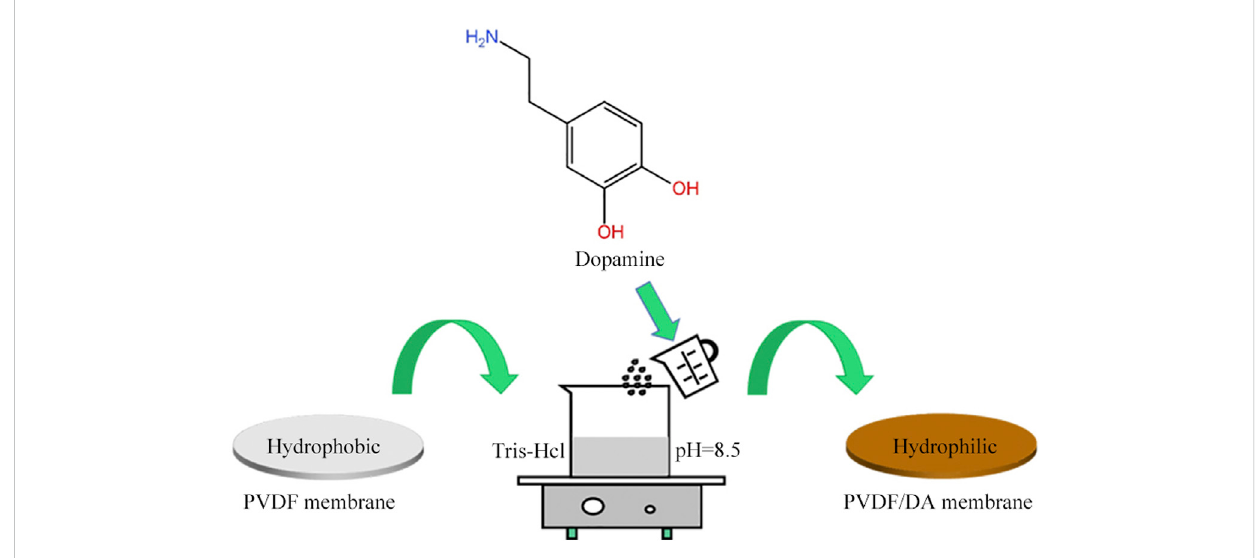
FIGURE 1 Procedure of the dopamine-modi fi ed PVDF